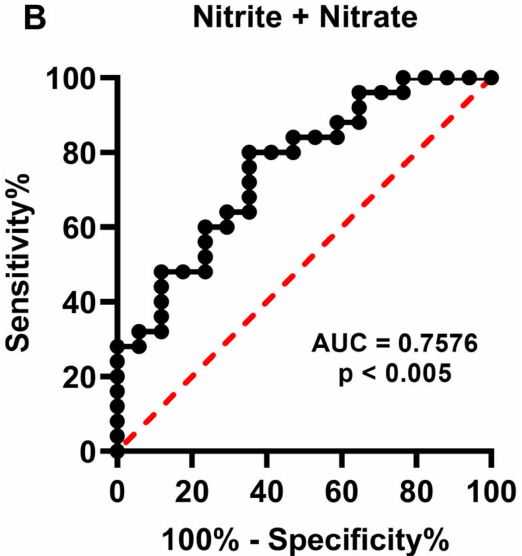
Figure 7. Receiver Operating Characteristic (ROC) curves of the sum of oxypurines ( A ) and nitrite + nitrate ( B ) determined in culture media of two groups of human embryos categorized ac- cording to morphological quality using the Gardner scale system. The significance of the Area Under the Curve (AUC) is indicated in each panel. The sum of oxypurines = hypoxanthine + uric